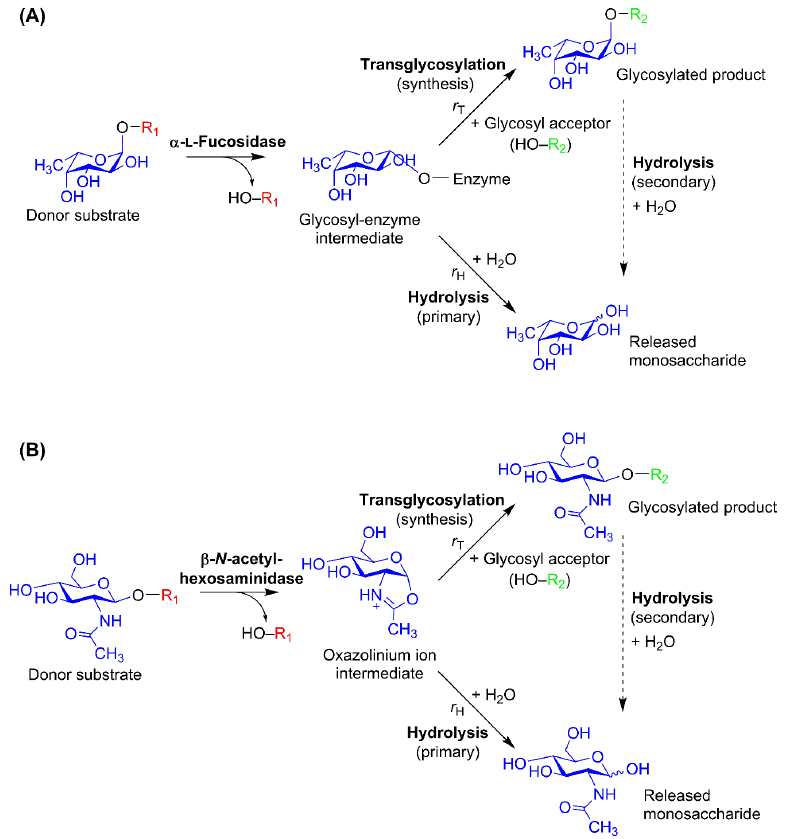
Figure 2. Reaction scheme sketches for glycosidase-catalyzed transglycosylation, which takes place in competition with substrate hydrolysis [49,68]. ( A ) Classical Koshland double-displacement mechanism exemplified by the α - l -fucosidase reaction: The intermediate, which is in the opposite anomeric configuration compared to the substrate and product as per the double displacement mechanism of retaining glycoside hydrolases (GHs), is attacked by a nucleophile. If this nucleophile is water, (primary) hydrolysis occurs. If a glycosyl acceptor performs the nucleophilic attack, transglycosylation occurs. ( B ) Substrate-assisted reaction mechanism of the GH20 β - N -acetylhexosaminidases [65]. For both reaction mechanisms, the resulting glycosylated product may also be subject to (secondary) hydrolysis catalyzed by the same glycosidase. The balance between the transglycosylation rate ( r T ) and the hydrolytic rate ( r H ) is governed by the reaction conditions as well as by enzyme properties, which can be altered through protein engineering. Regioselectivity in the product formation may vary. In HMO synthesis, R 1 and R 2 are glycosides, but for transglycosylation, in general, they can be other compounds, e.g., primary